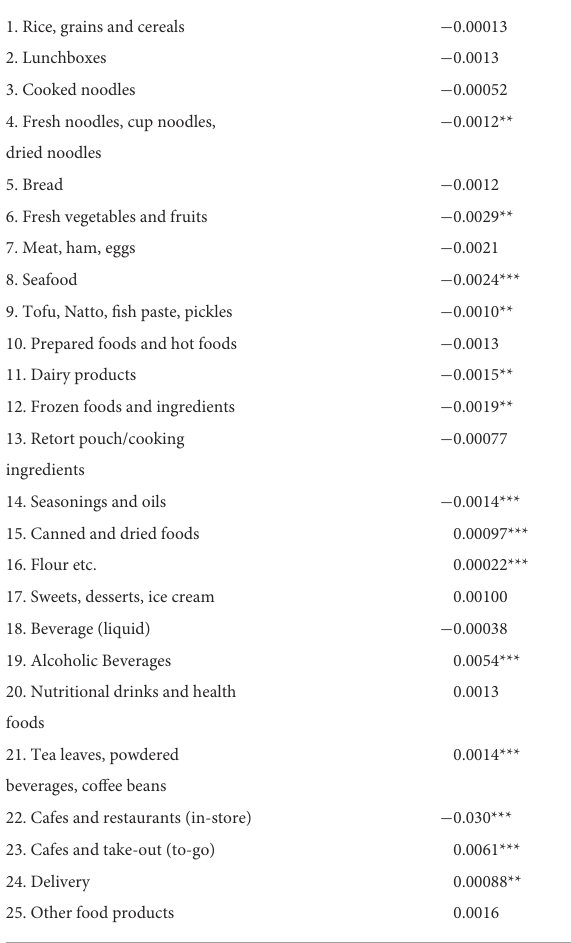
TABLE 5 Result of the year dummy variable (Model